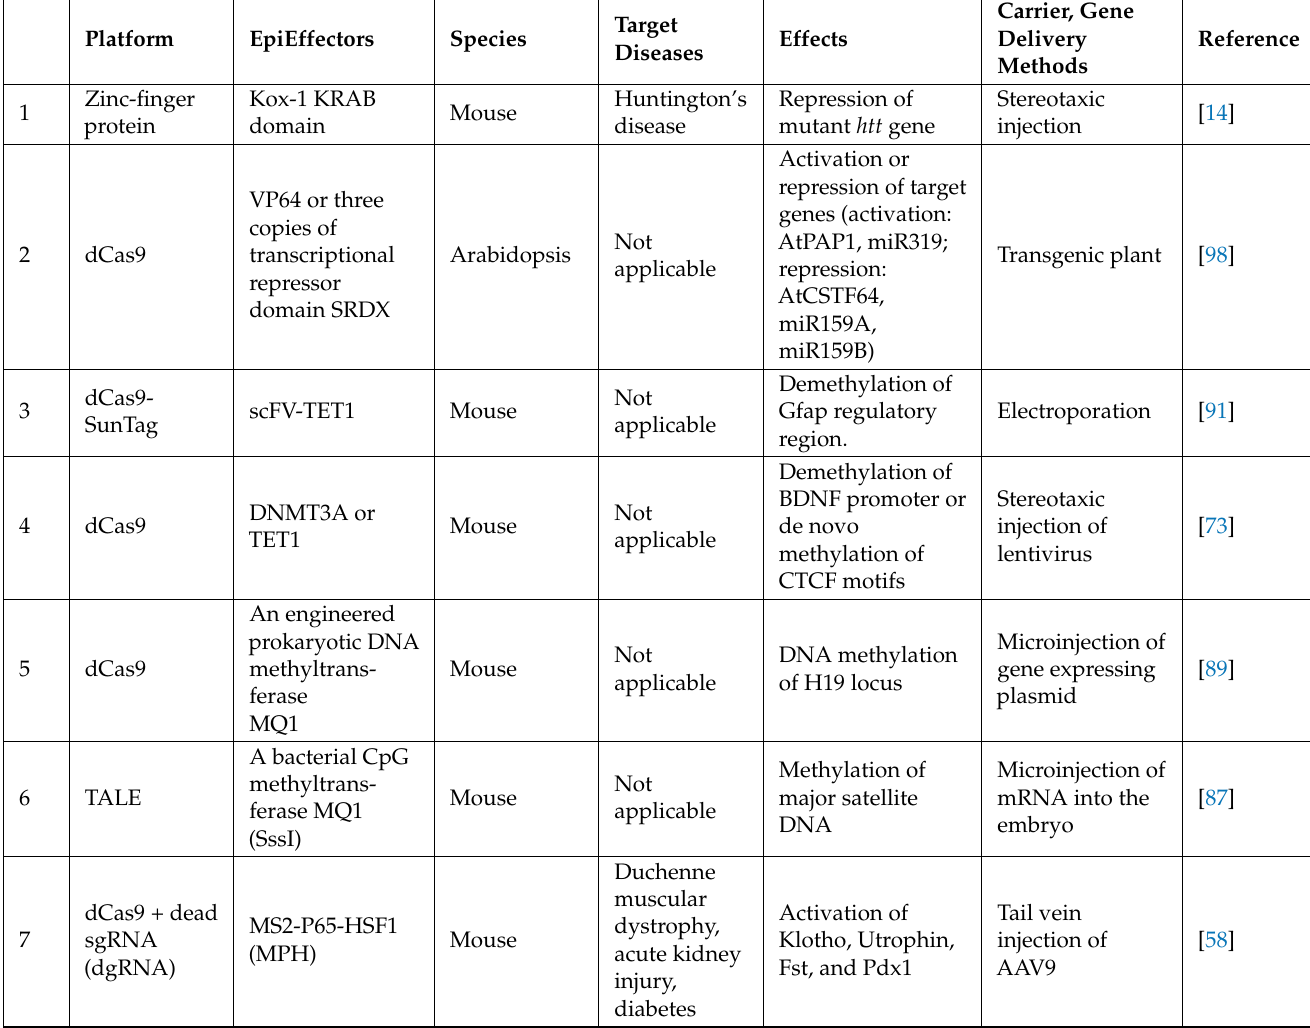
Table 2. Epigenome-editing studies in